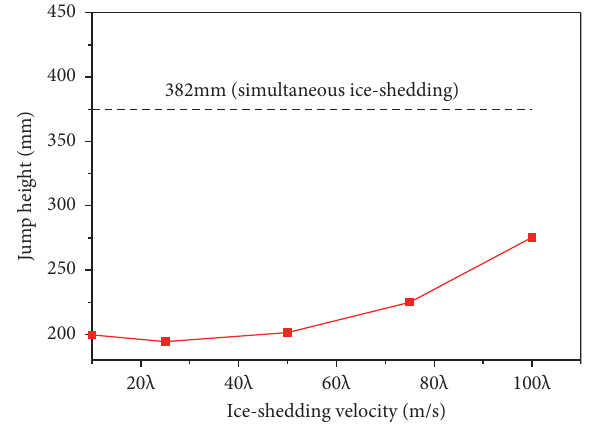
Figure 7: The variation of the jump height with ice-shedding